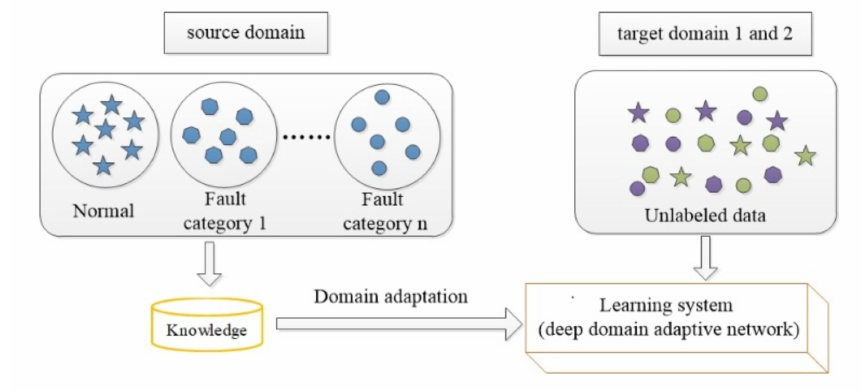
Figure 7. The learning process of multi-target domain adaptation.